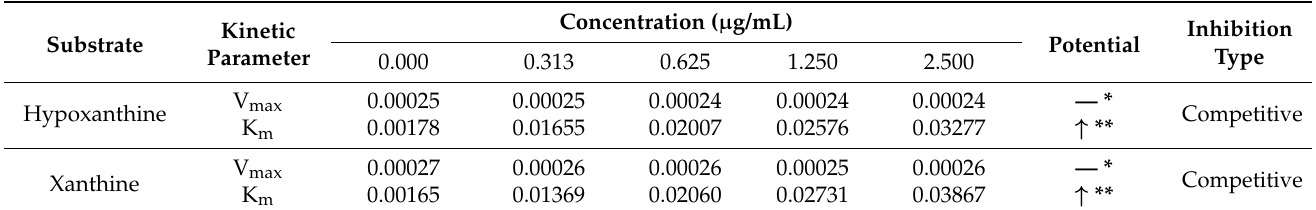
Figure 3. Lineweaver–Burk plots of allopurinol: ( a ) hypoxanthine as the substrate; ( b ) xanthine as the substrate. Table 5. Kinetic parameters of allopurinol against xanthine oxidase in enzyme kinetic study.